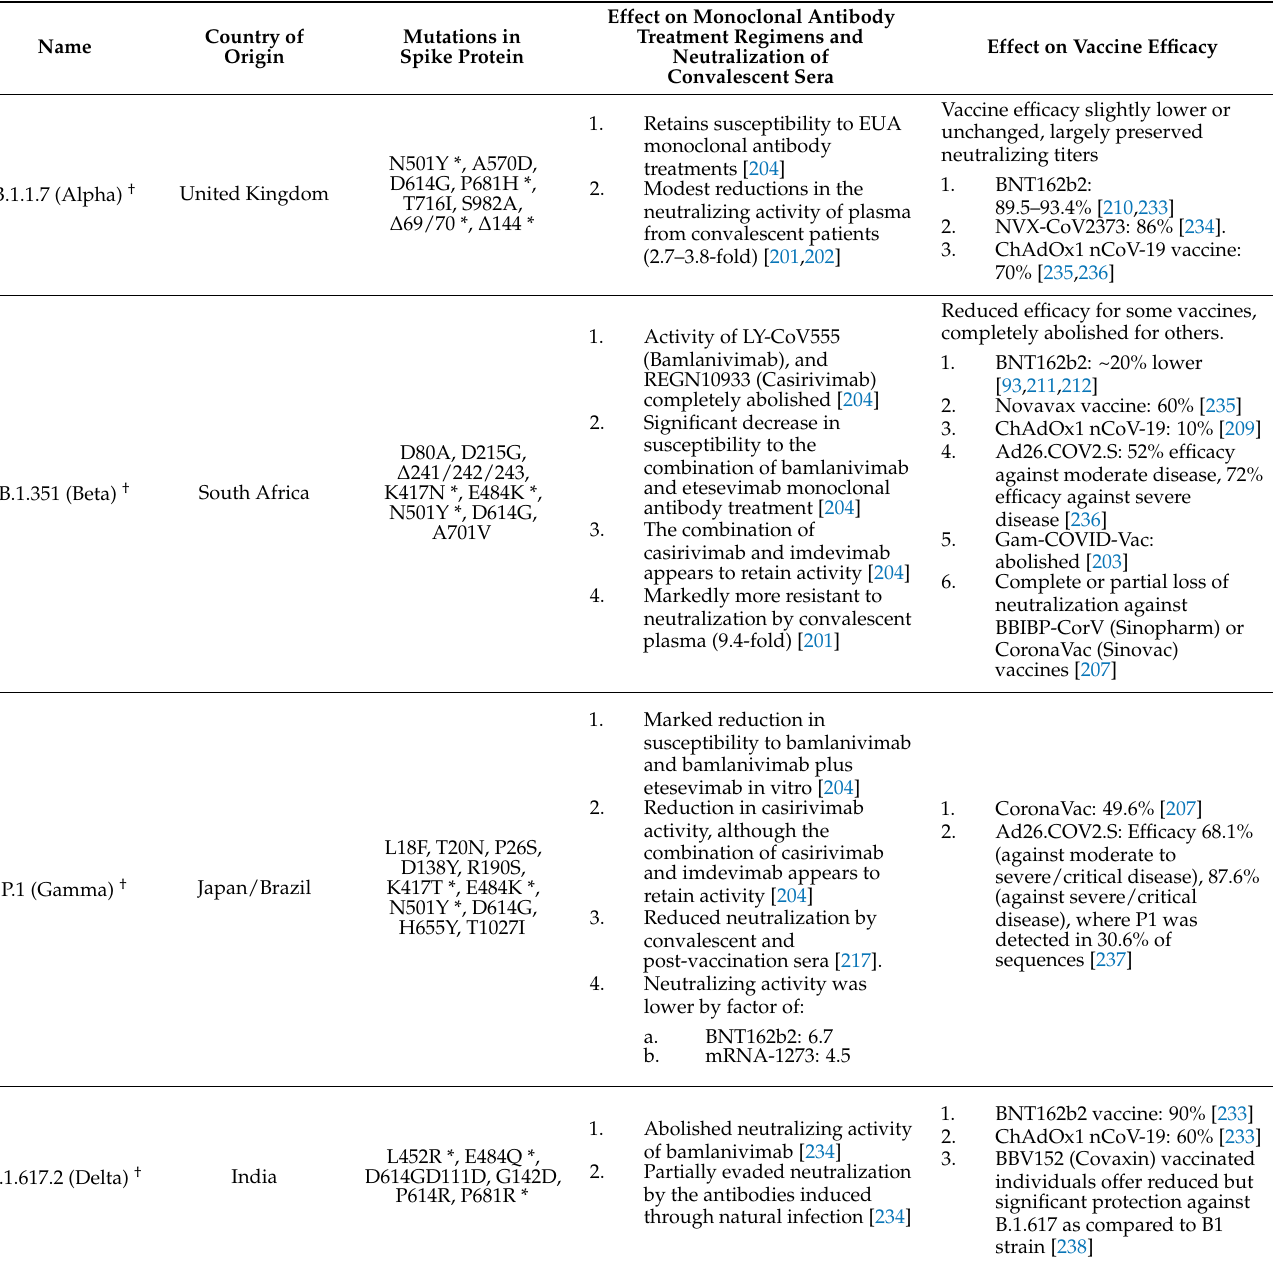
Table 6. Effect of SARS-CoV-2 variants on vaccine efficacy and